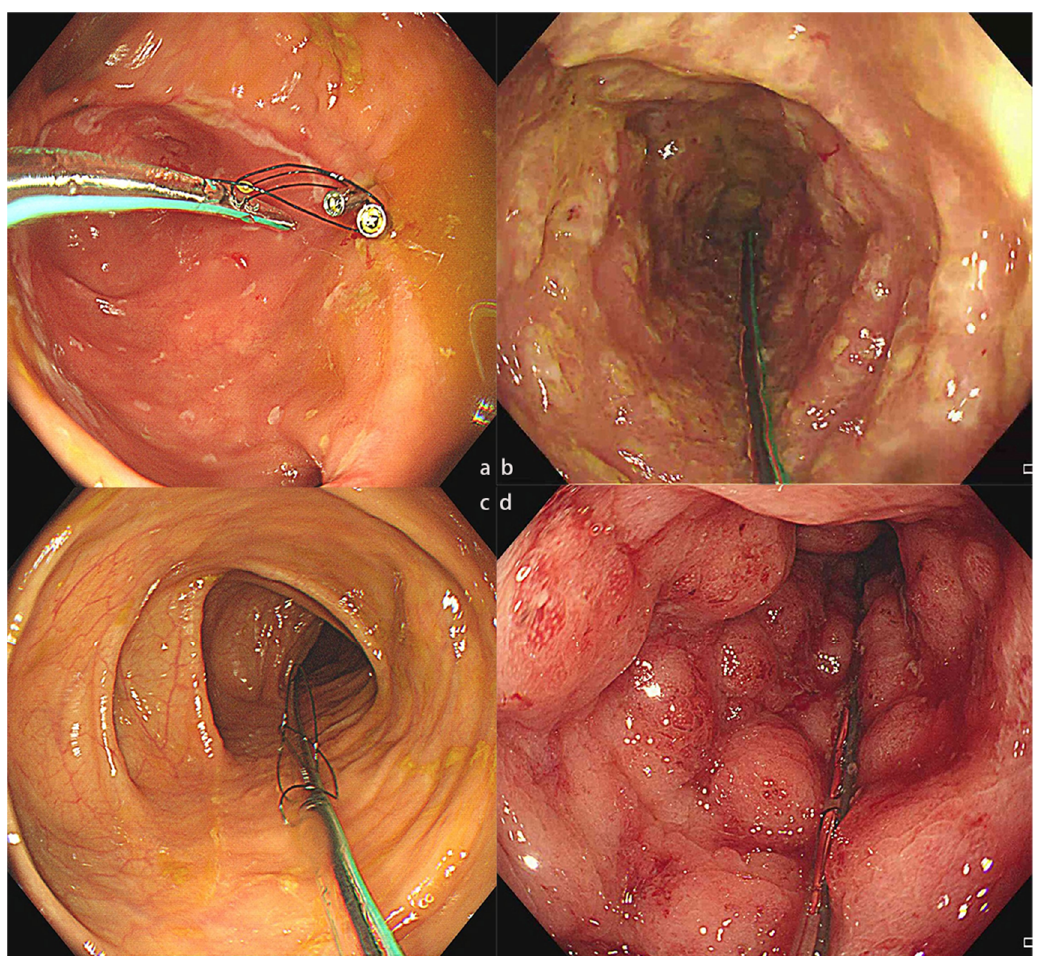
Figure 2. The colonic TET tube used in different disease conditions. ( a ) The colonic TET tube in the intestine of a patient with CD. ( b ). The colonic TET tube in the intestine of a patient with rCDI. ( c ) The colonic TET tube in the intestine of a patient with IBS. ( d ) The colonic TET tube in the intestine of a patient with UC. CD, Crohn’s disease; rCDI, recurrent Clostridioides difficile infection; IBS, irritable bowel syndrome; UC, ulcerative colitis; TET, transendoscopic enteral tubing.